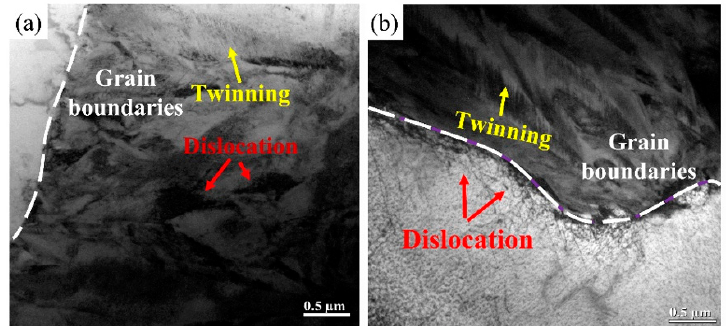
Figure 4. Bright field images at grain boundaries after solution treatment at different temperatures: ( a ) 1100 °C; ( b ) 1200 °C.